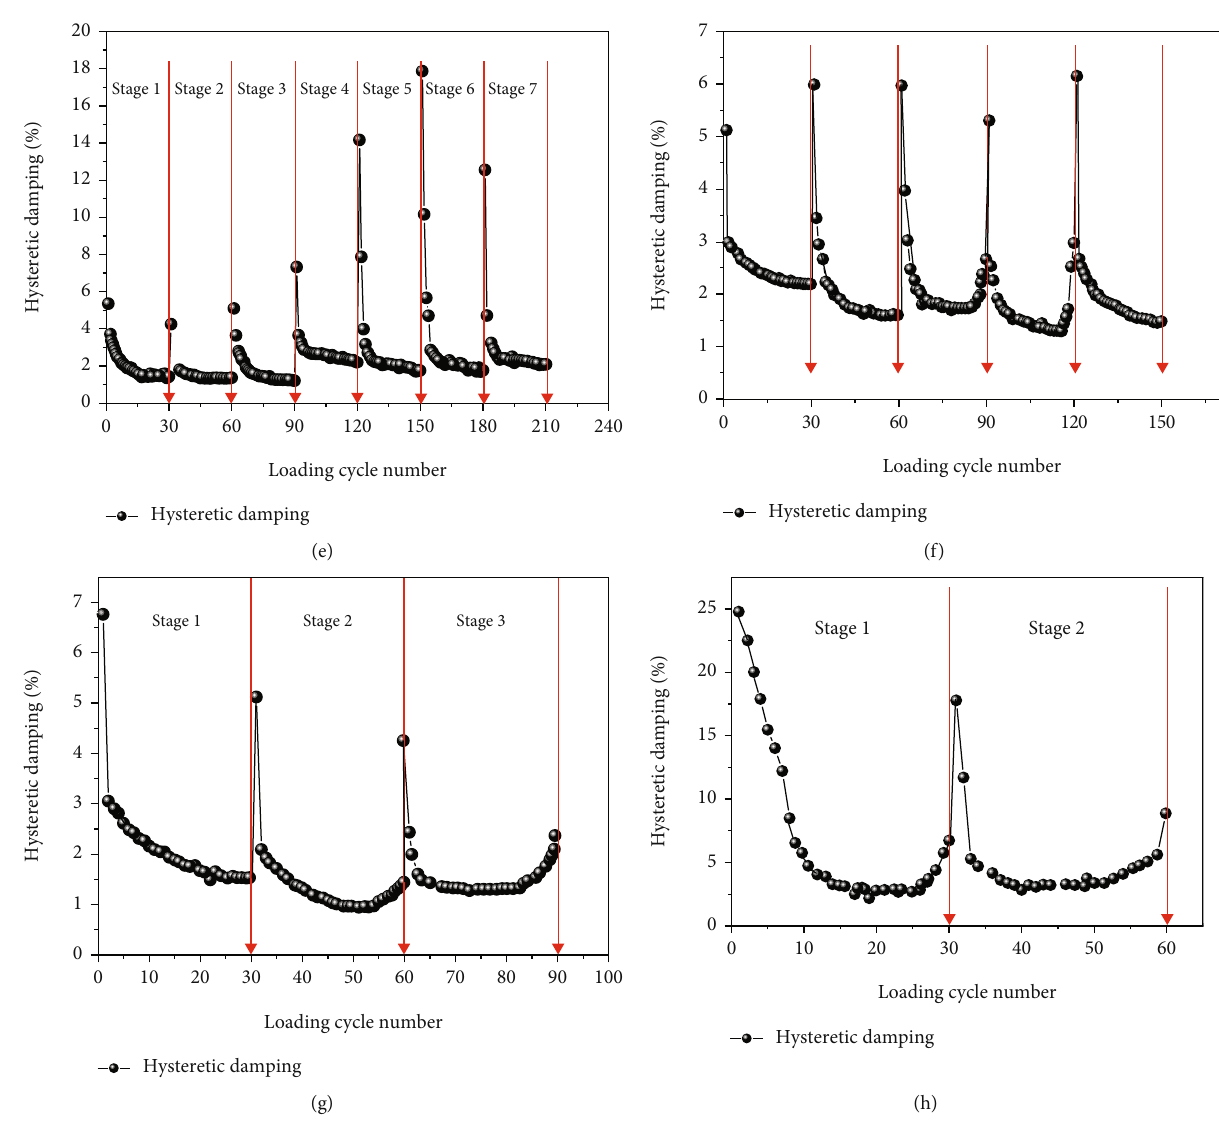
D Figure 5: Evolution of the dynamic elastic modulus ( E d ) and hysteretic damping ratio ( r ) with cyclic number for sample with natural fracture volume ratio of 0.08%, 0.12%, 0.56%, and 2.11%, respectively. (a – d) Plots of E d against loading cycle number during sample deformation; (e – f) plots of the D r against loading cycle number during sample